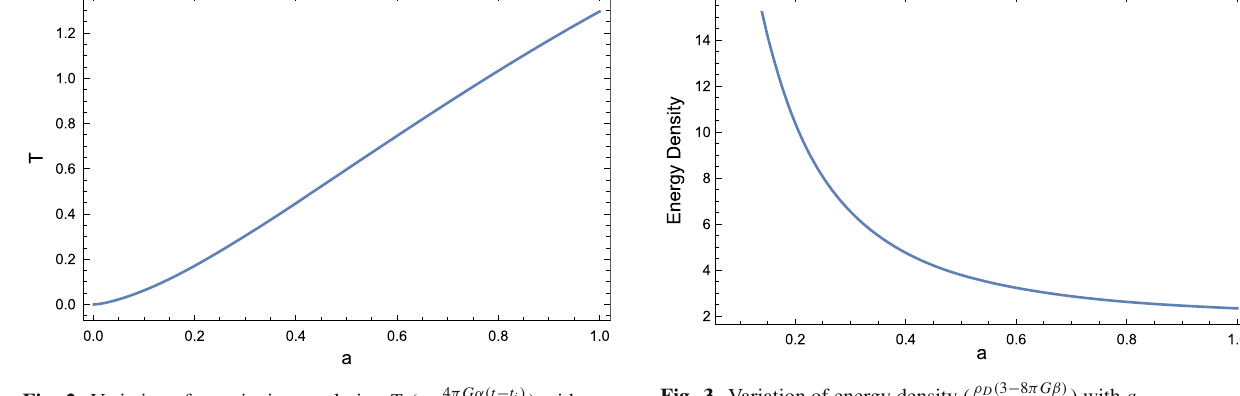
Fig. 2 Variation of cosmic time evolution T ( = 4 π G α( t − t i ) γ ) with a Fig. 3 Variation of energy density (